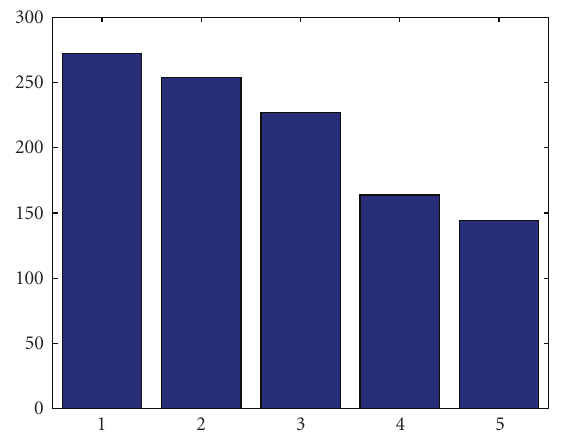
Figure 1: Generalized Hankel Singular Values ( γ i ).